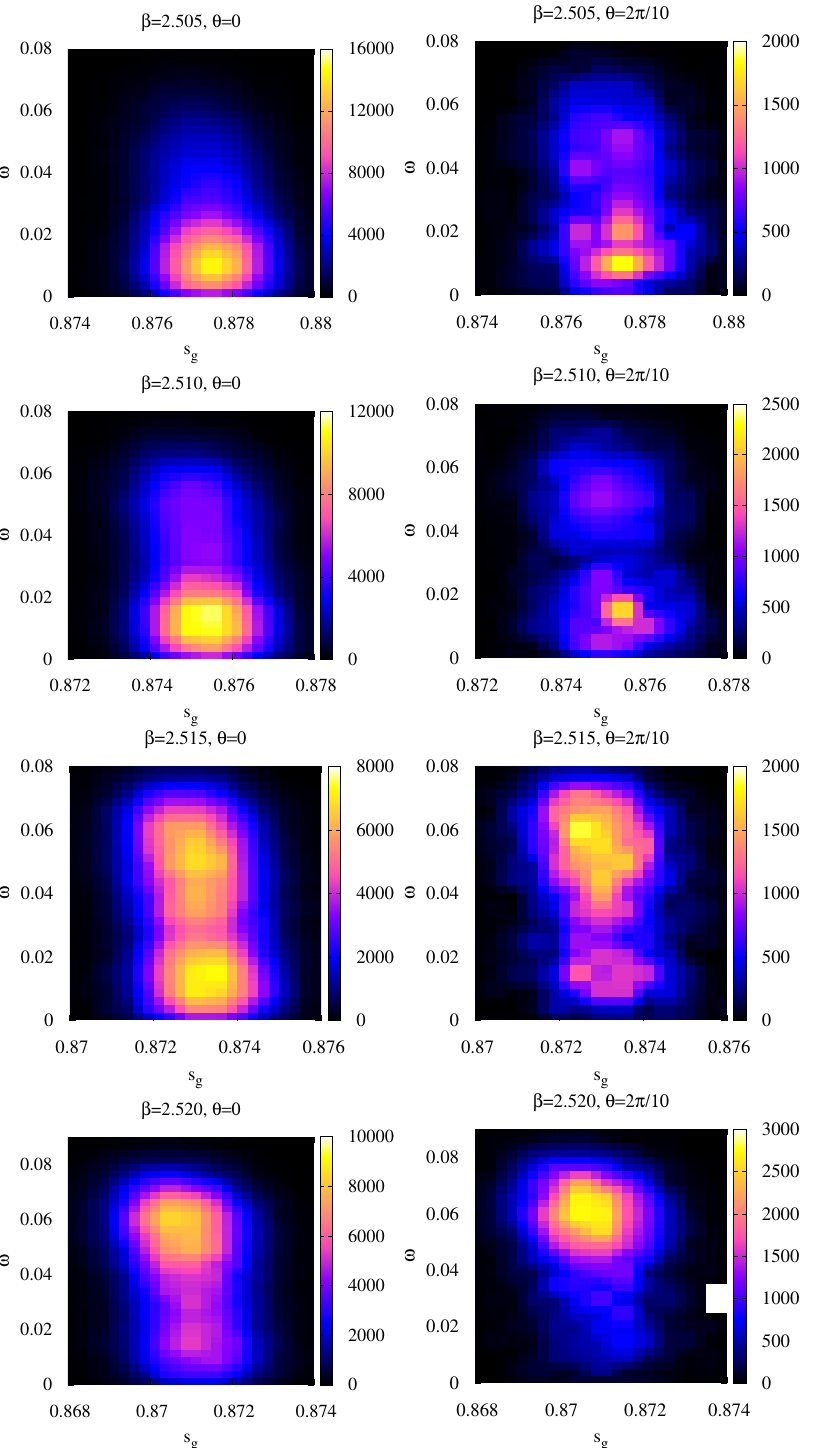
Figure 3 . Two dimensional histogram on the s g - ω plane at β = 2 . 505 2.510, 2.515, 2.520 from top to